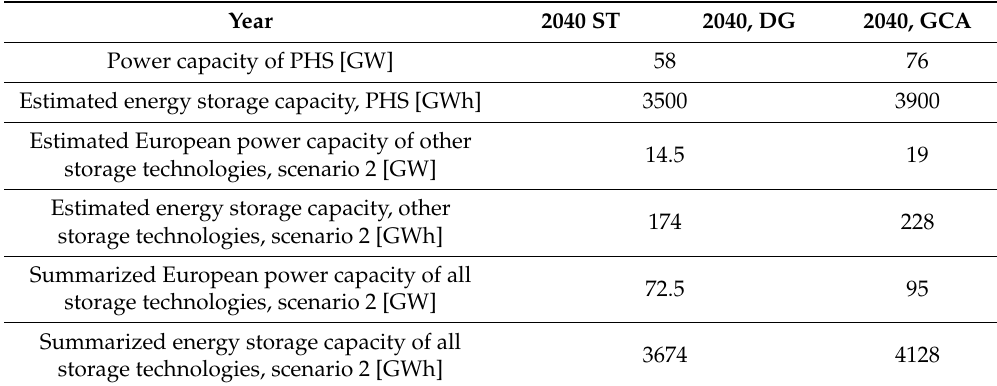
Table 8. Power capacity and energy storage capacity results of the European energy storage systems in